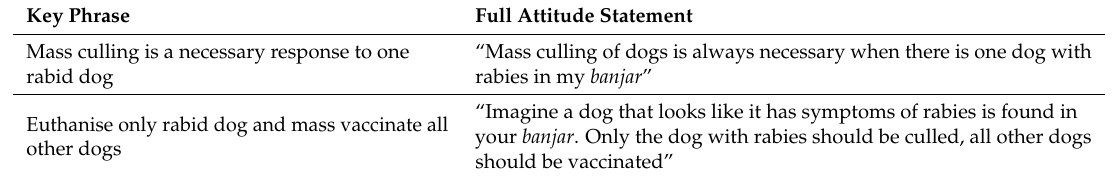
Table 2. Full attitude statements and key phrases as used in Figures 10 and 11.